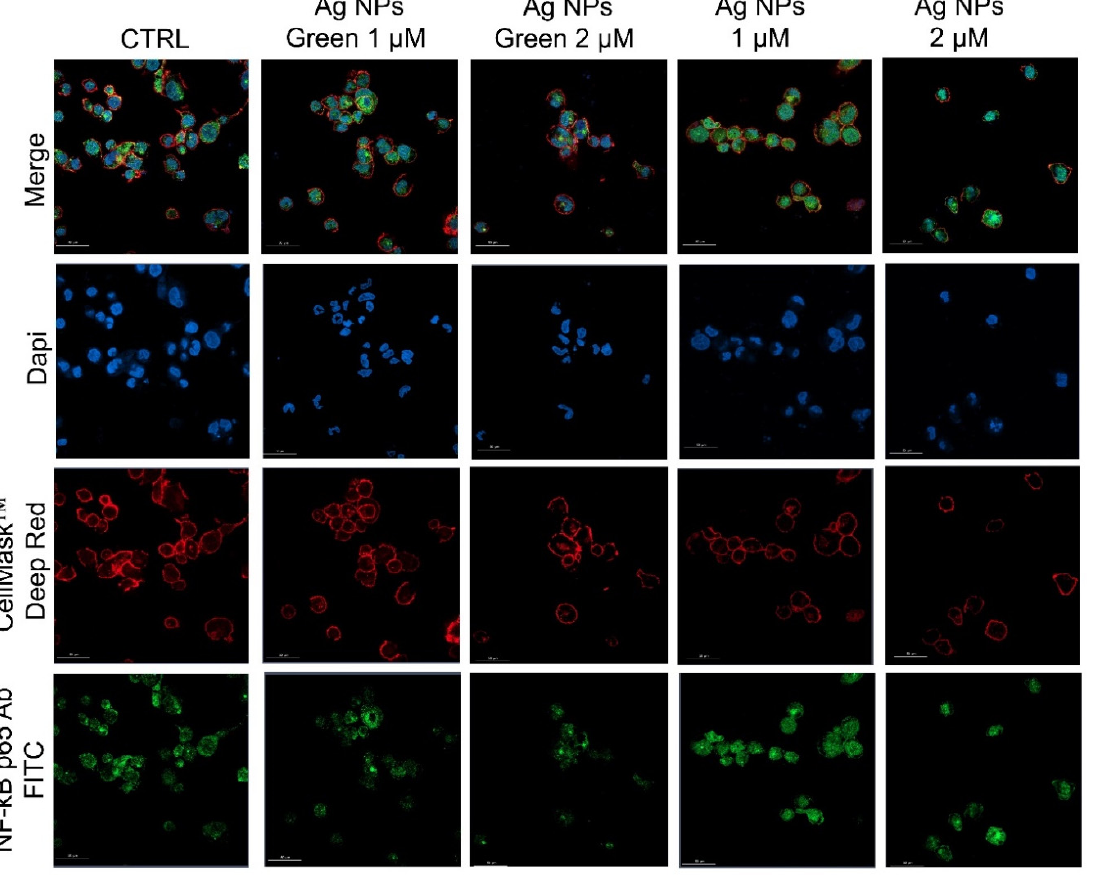
Figure 5. Representative confocal images of untreated macrophages (M0, control) and macrophages exposed to the 1 µ M and 2 µ M of green Ag NPs and conventional Ag NPs for 24 h. The cells were fixed and then stained. The nuclei were labeled with DAPI (blue), Actin cytoskeleton with CellMask™ (red), and NF- κ B with NF- κ B p65 Antibody (F-6) FITC (green intensity signal). Scale bar is 50 µ